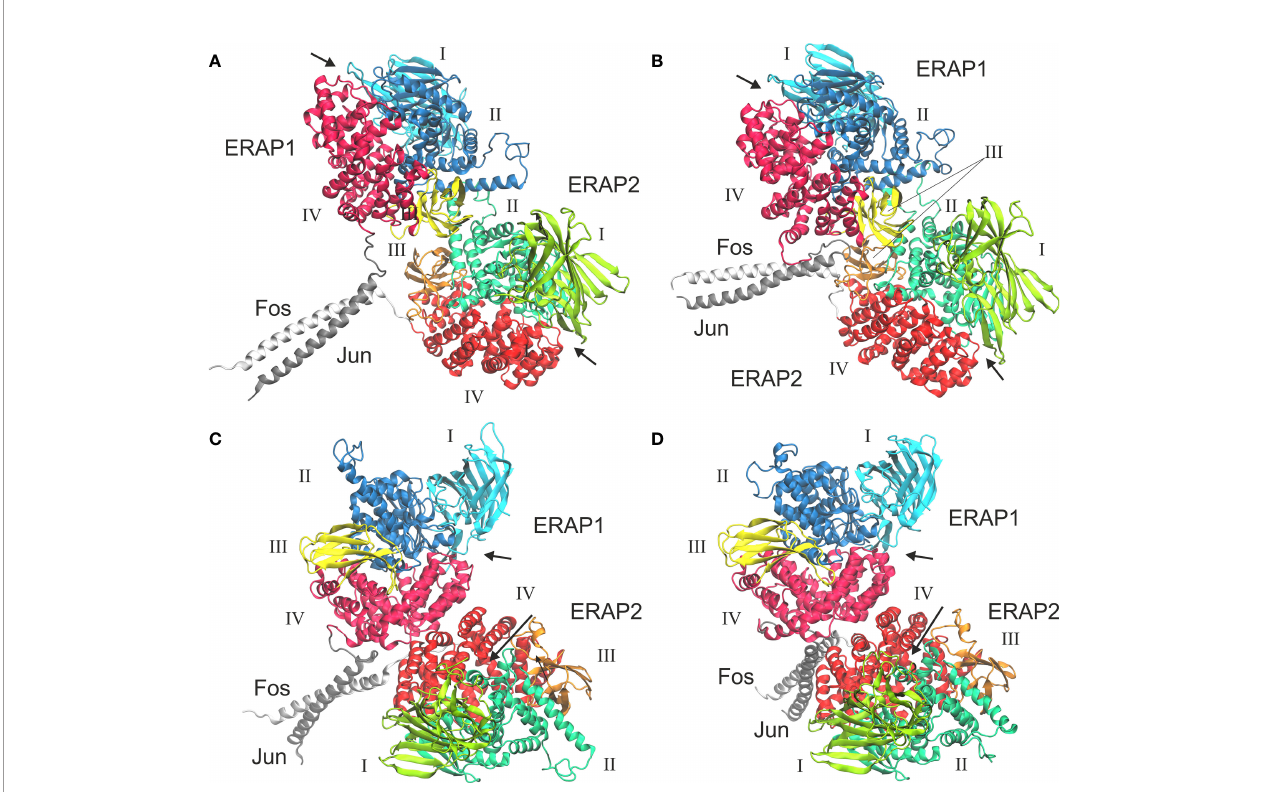
FIGURE 6 | Models of ERAP1 – c-Jun/ERAP2 – c-Fos based on two different topologies. (A) Initial, energy minimized dimer based on model B2 and (B) representative structure from a MD simulation, calculated as the centroid of the highest populated cluster of conformations (40% fraction of the trajectory) with respect to the RMSD of the C a atoms excluding the Jun/Fos linker residues. (C) Initial, energy minimized structure of the IRAP-based model C2, and (D) representative structure of the highest populated cluster of conformations (43% fraction of the trajectory) calculated from a MD simulation. Arrows indicate the substrate entrance site.